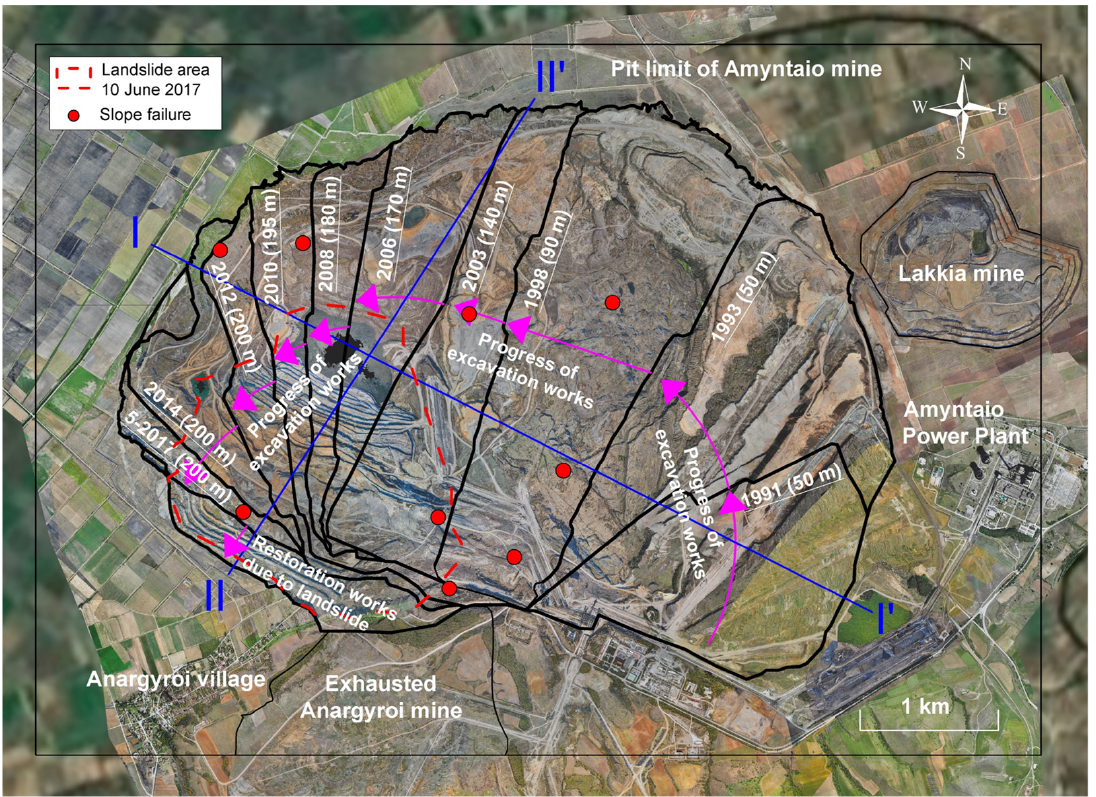
Figure 5. Progress of excavation works and corresponding maximum depths of the Amyntaion mine. Blue lines show cross sections I-I and II-II.